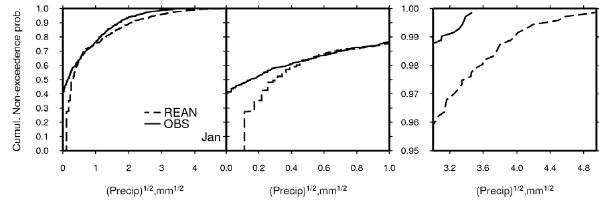
Figure 3. Cumulative distribution function (CDF) for daily precipitation for January at 2 Fig. 3. Cumulative distribution function (CDF) for daily precip- itation for January at Reanalysis grid point located at 37.1422 ◦ N, Reanalysis grid point located at 37.1422 ° N, 110.625 ° W. Reanalysis is compared to gridded 3 110.625 ◦ W. Reanalysis is compared to gridded observations aggre- observations aggregated to reanalysis scale. Left panel shows entire CDF, while center panel 4 gated to reanalysis scale. Left panel shows entire CDF, while center panel shows only daily precipitation values below 1mm, and right shows only daily precipitation values below 1 mm, and right panel shows precipitation over 9 5 panel shows precipitation over 9mm/d. mm/d. 6